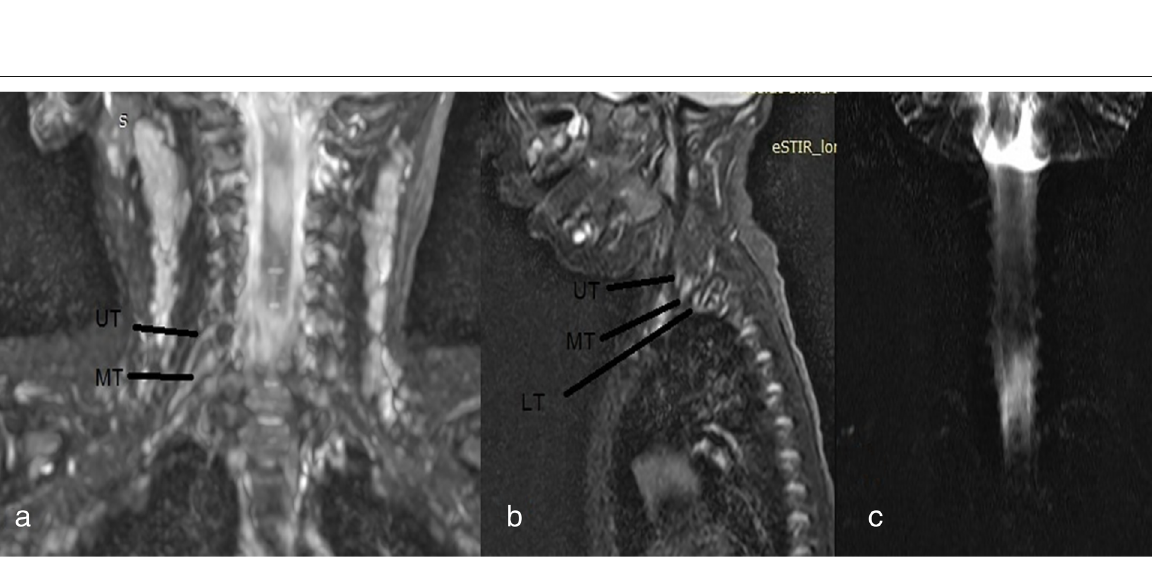
Fig. 3 An 11-month-old male patient presented with right-sided obstetric brachial plexus injury. a MIP of coronal STIR and b sagittal STIR showing mildly thickened with an increased signal of the upper trunk (UT) and middle trunk (MT) compared to the lower trunk (LT) of the right brachial plexus. c Radial myelography showing no meningocele formation at right-sided neuroforamina. Operative data are partially injured right- sided upper and middle